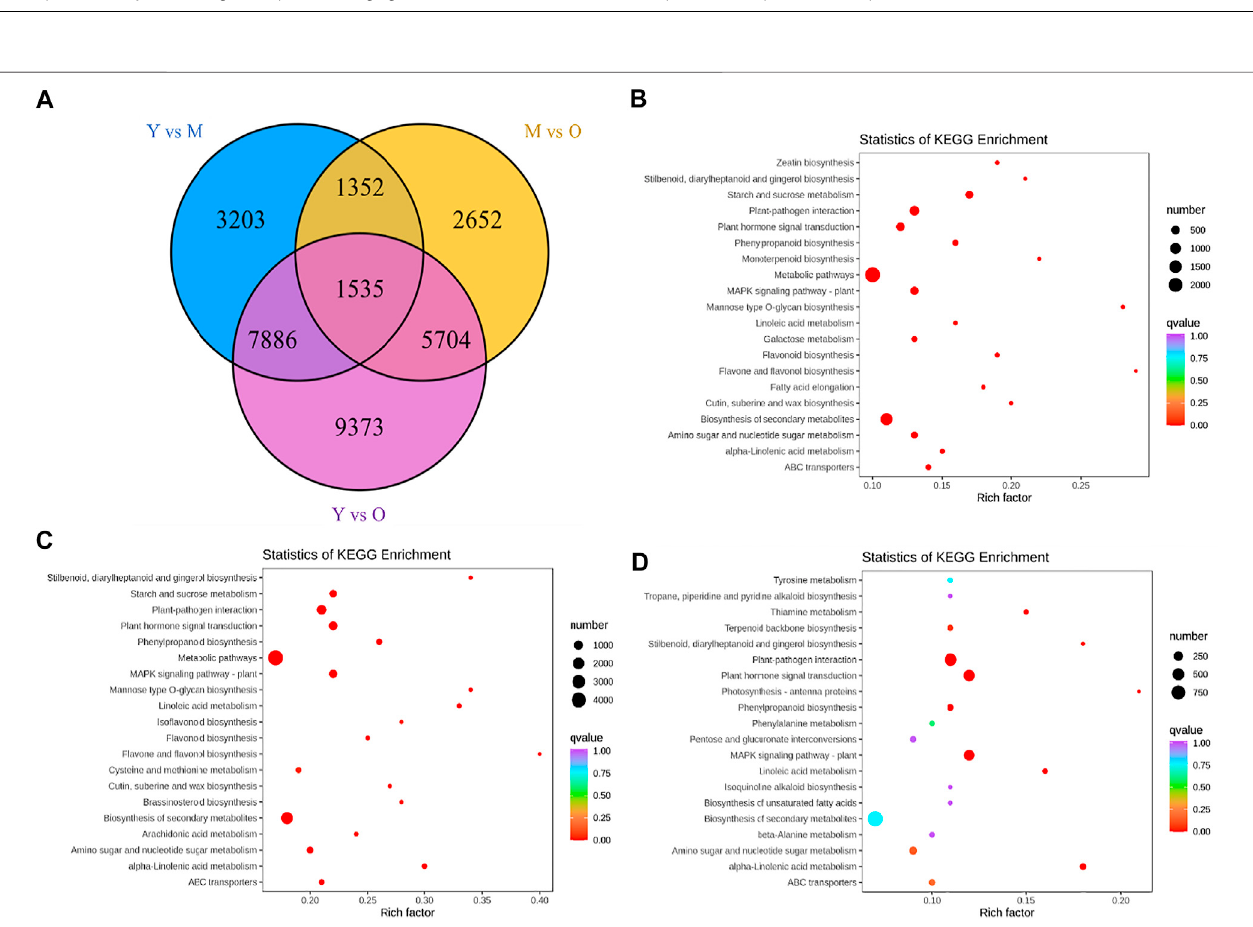
FIGURE2|(A) Venndiagramrepresentingnumberofdifferentiallyexpressedgenes(DEGs)speci fi ctoeachtreatmentcomparisonandcommonDEGsinthethree treatment comparisons. KEGG enrichment scatter plots representing pathways to which DEGs were signi fi cantly enriched in (B) Y vs. M, (C) Y vs. O, and (D) M vs O.